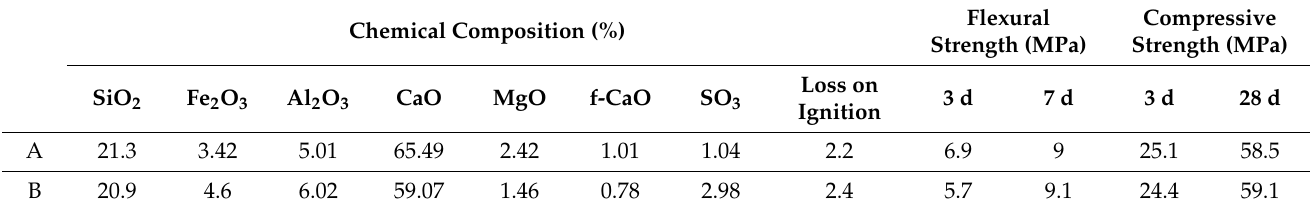
Table 1. Chemical Composition and Physical Properties of Cement.